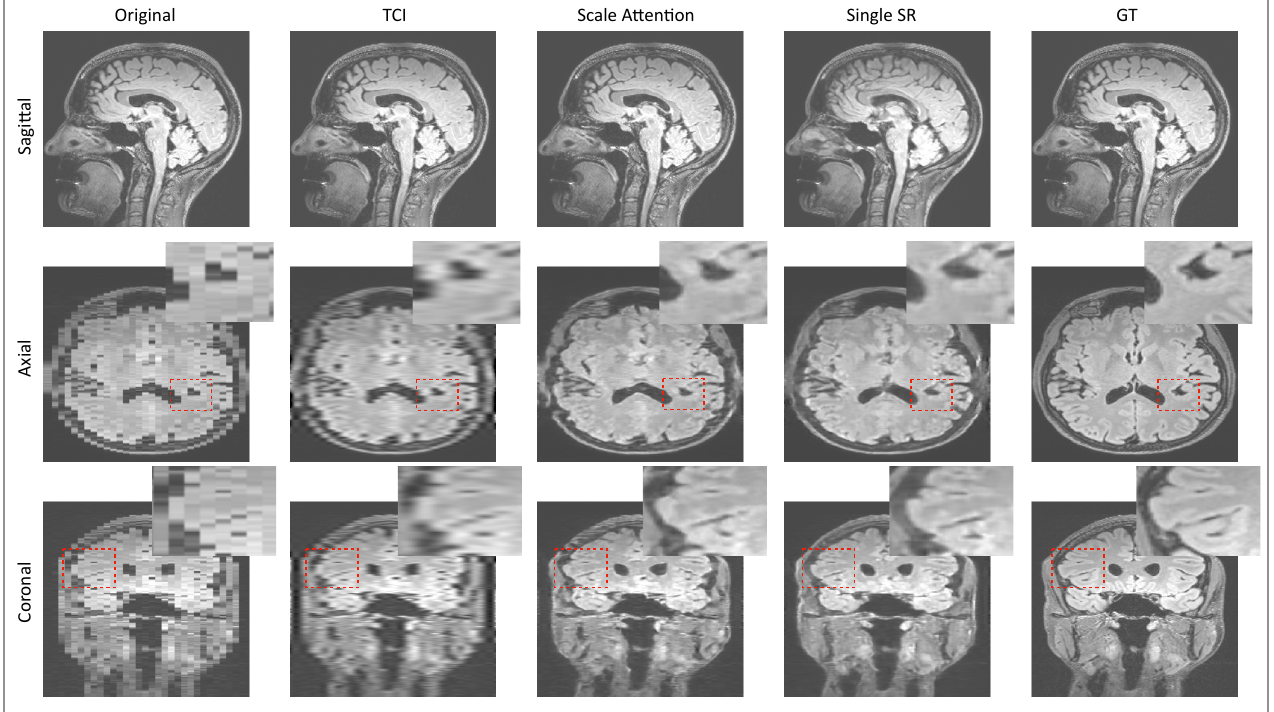
Figure 4. Comparison between the scale-attention model and cubic interpolation on T2-FLAIR brain MRI at different scales. TCI: tricubic interpolation; GT: ground